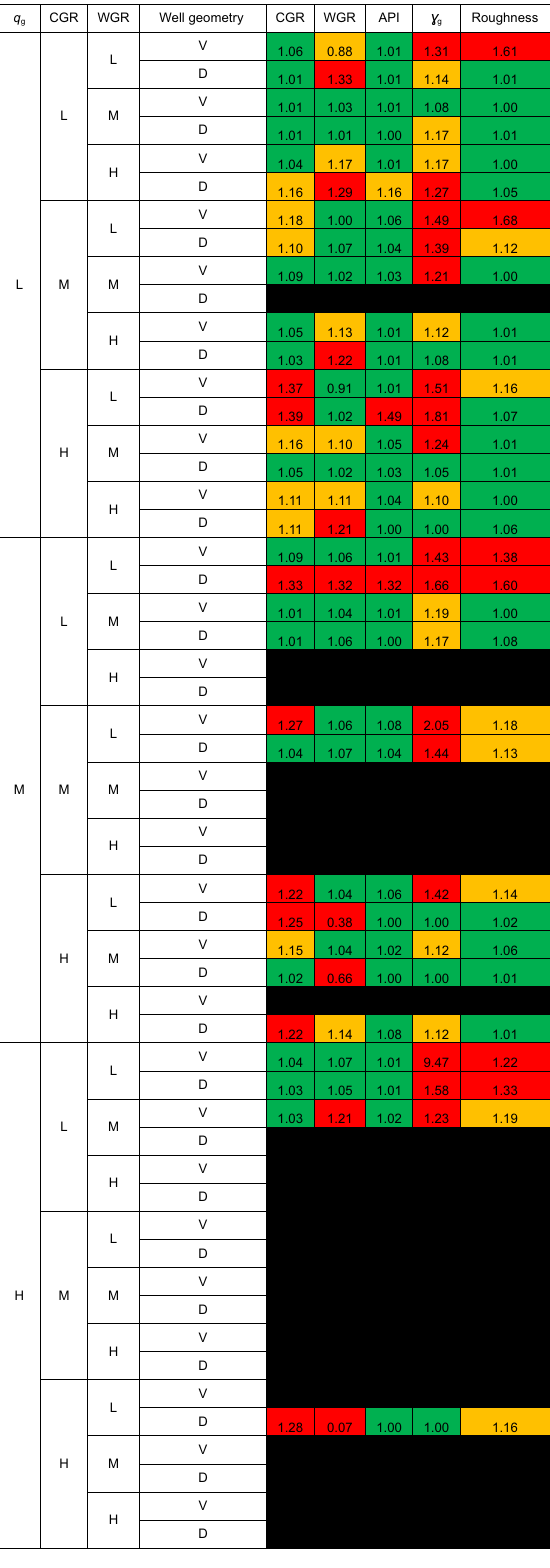
Table 8 Effect of changing input parameters on